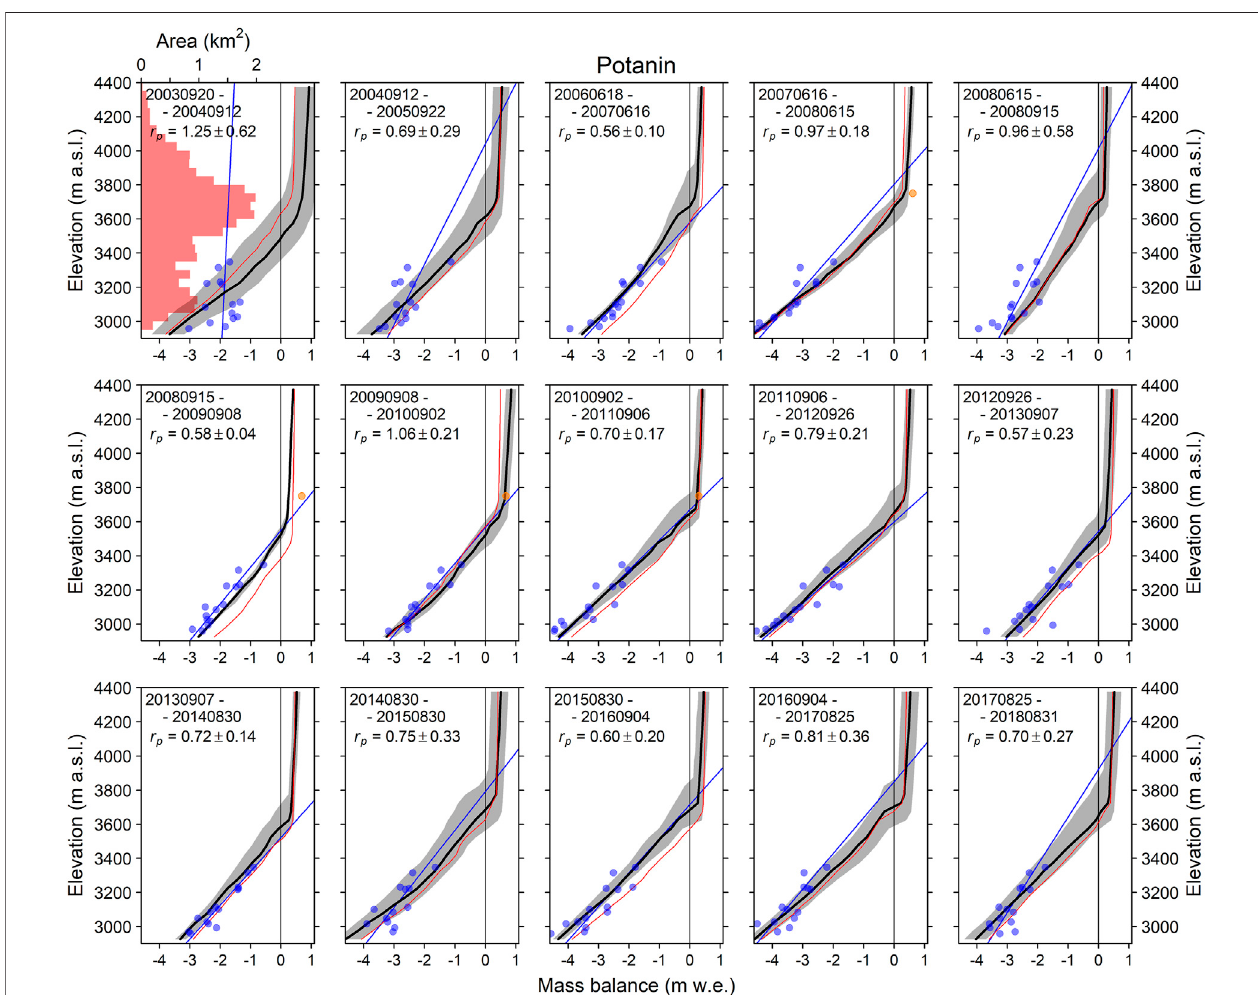
FIGURE3| ObservedandmodelledmassbalancesofPotaninGlacier.Theobservation period foreach panel(startingand endingdatesinyearmonth dayformat: YYYYMMDD)islistedatthetop.Redshadingintheupperleftpaneldenotesthehypsometryoftheglacierat50-melevationbands(upperaxis).Thebluedotsdenotethe observed mass balance, and the blue line denotes a linear regression obtained for band-mean speci fi c mass balances, which were averaged at a 50-m elevation band, respectively.Theblacklineandgreyshadedregiondenotethemodelledmass-balancepro fi leanditsvariabilityduetotheprecipitationparameter( r p ineachpanel), respectively. The thin red line denotes the modelled mass-balance pro fi le without the precipitation calibration. Orange dots denote the mass balance determined via a pollen analysis in a pit (Nakazawa et al., 2015).